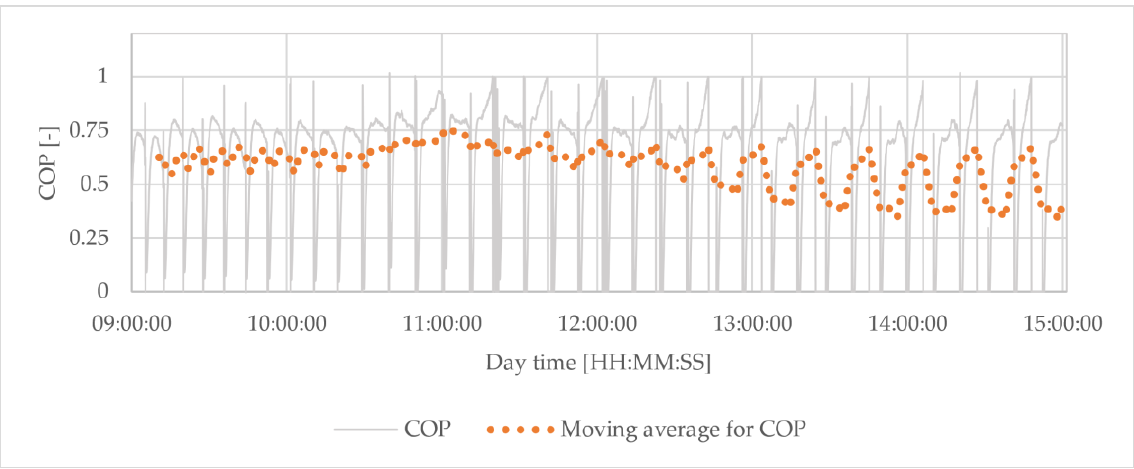
Figure 7. The fluctuation of heating and cooling power values over time for 22nd July.